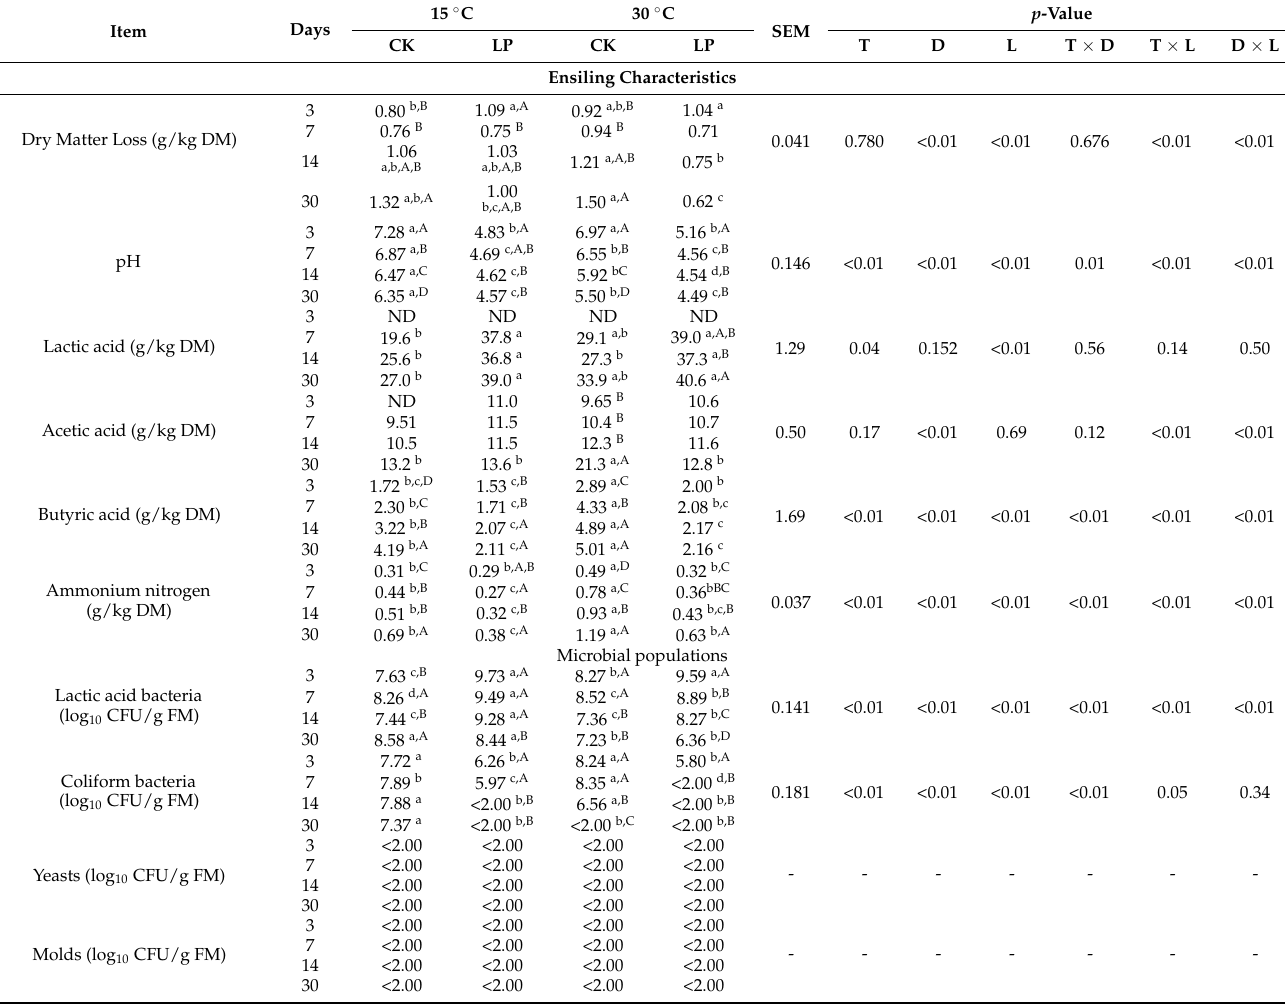
Table 2. The effect of Lactobacillus plantarum (LP) on the fermentation quality and microbial population of B. papyrifera leaves silage at different temperatures (15 ◦ C, 30 ◦